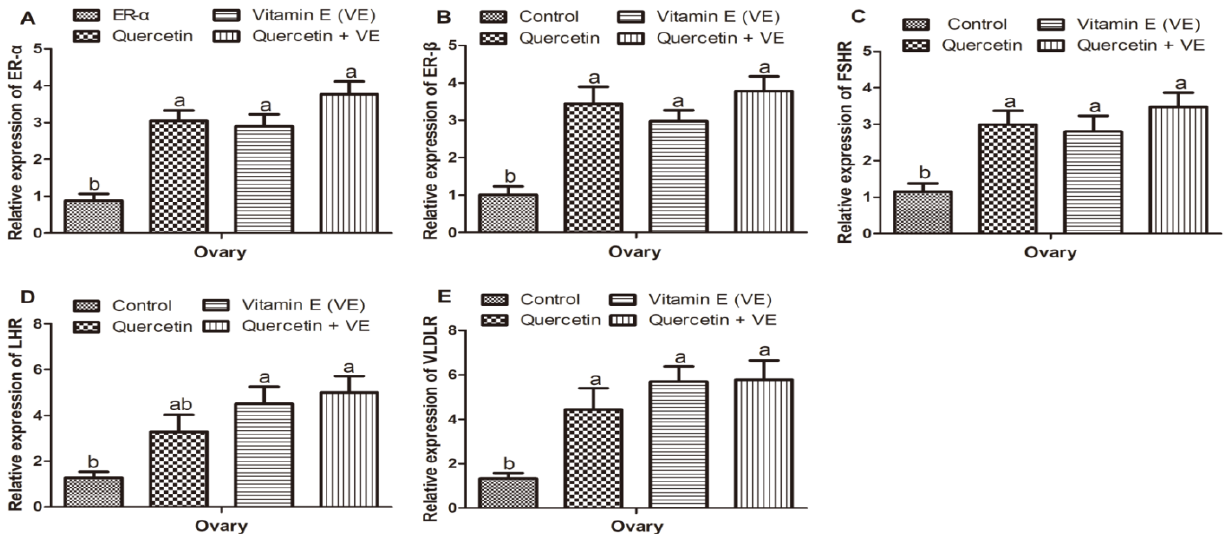
Figure 7. Effects of quercetin, vitamin E, and quercetin + vitamin E on the levels of mRNA expression of hormone receptors in the ovary of aging breeder hens. Levels of expression of ER- α ( A ), ER- β ( B ), FSHR ( C ), LHR ( D ), and VLDLR ( E ). The values are presented as the mean ± SD. Bars without the same letter differed significantly ( p < 0.05).